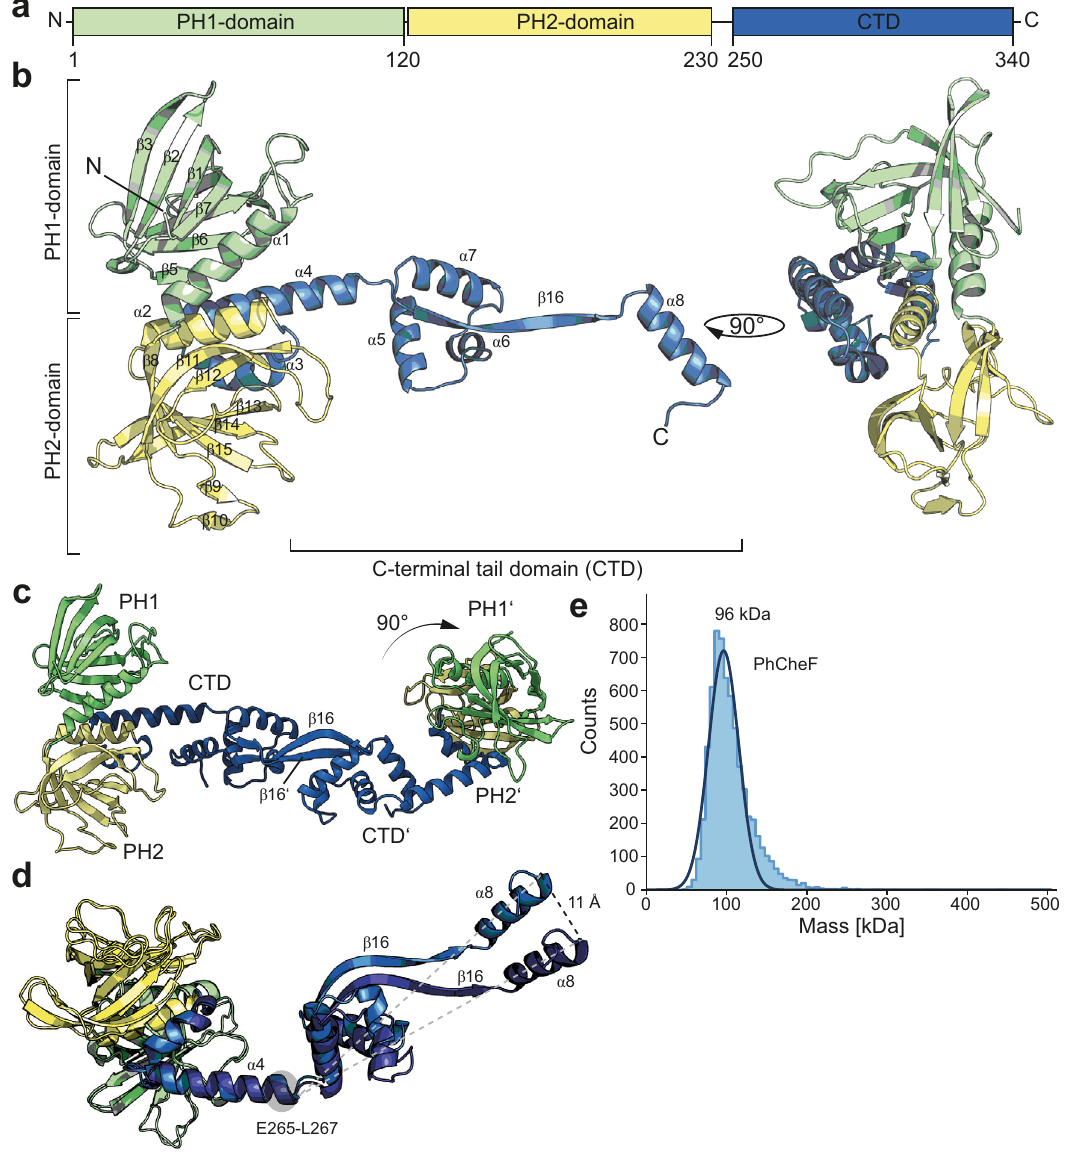
Fig. 1 The crystal structure of CheF reveals a twisted homodimer. a Domain architecture including amino acid boundaries of CheF. b Crystal structure of PhCheF with the two PH-domains colored in light green and light yellow and the CTD in blue, respectively. The right panel shows the structure rotated by 90°. c The asymmetric unit of the PhCheF structure reveals the presence of a dimer. The two monomers are twisted via their CTD ’ s resulting in the PH domains being rotated by 90°. d The two monomers of the CheF dimer exhibit inherent fl exibility through a region within helix α 4. e Mass photometry of PhCheF shows a single species of ∼ 96 kDa. Source data are provided as a Source Data fi